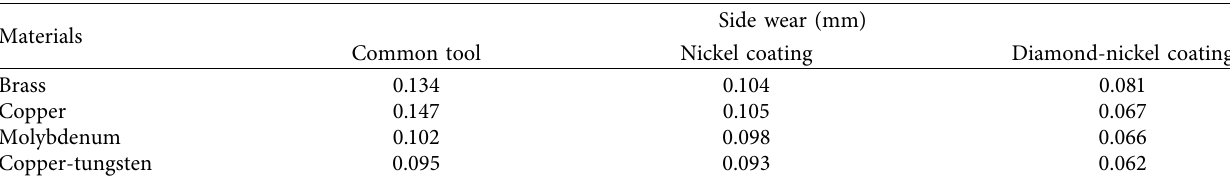
Figure 11: Shape change of brass-based composite tools. (a) Common tool. (b) Nickel-coated tool. (c) Diamond-nickel-coated tool. Table 8: Side wear of different coated